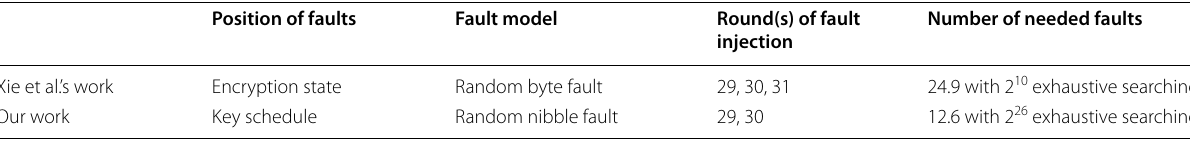
Table 8 The comparisons with Xie et al.’s work Position of faults Fault model Round(s) of fault